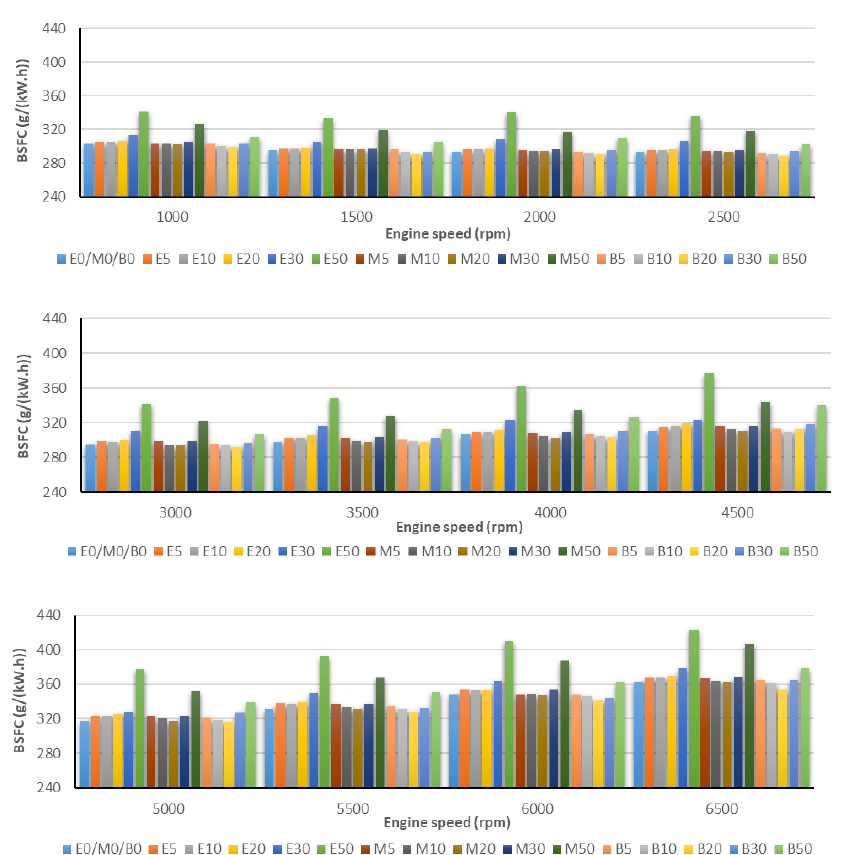
Figure 3. The results for BSFC obtained from blended alcohol fuels and net gasoline.